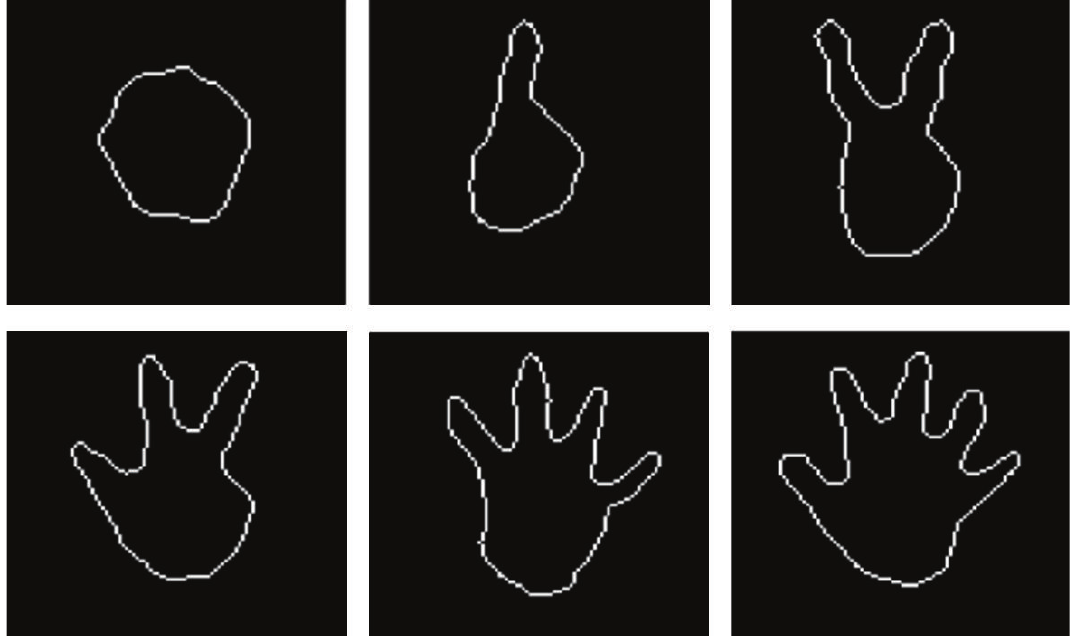
Figure 6: Examples of right hand outline images obtained by the proposed